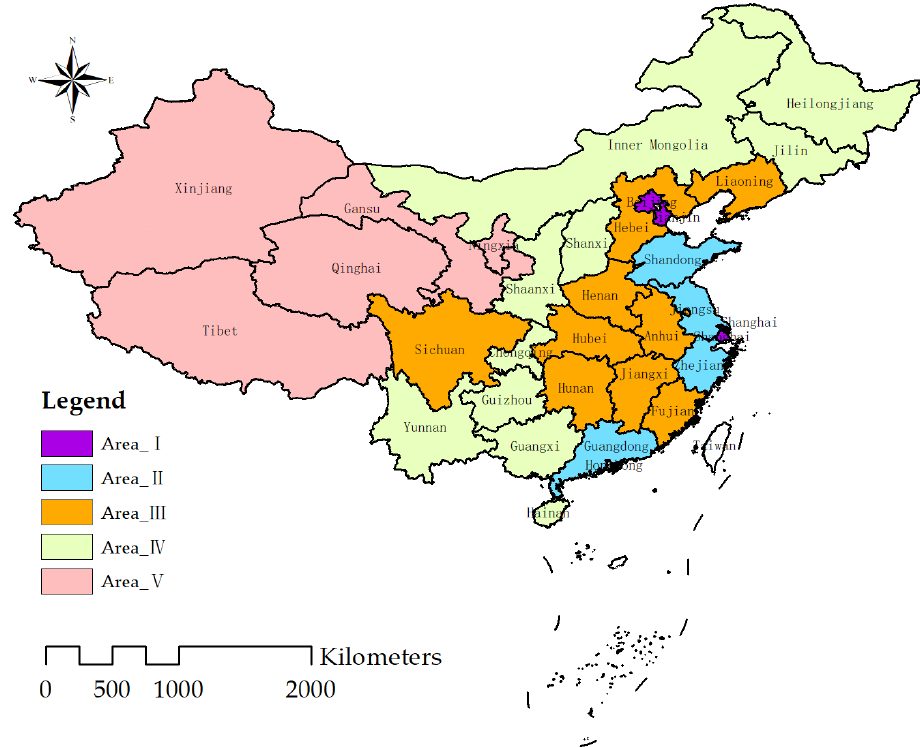
Figure 3. Clustering results of land fiscal ecological cost scale in 31 provinces.